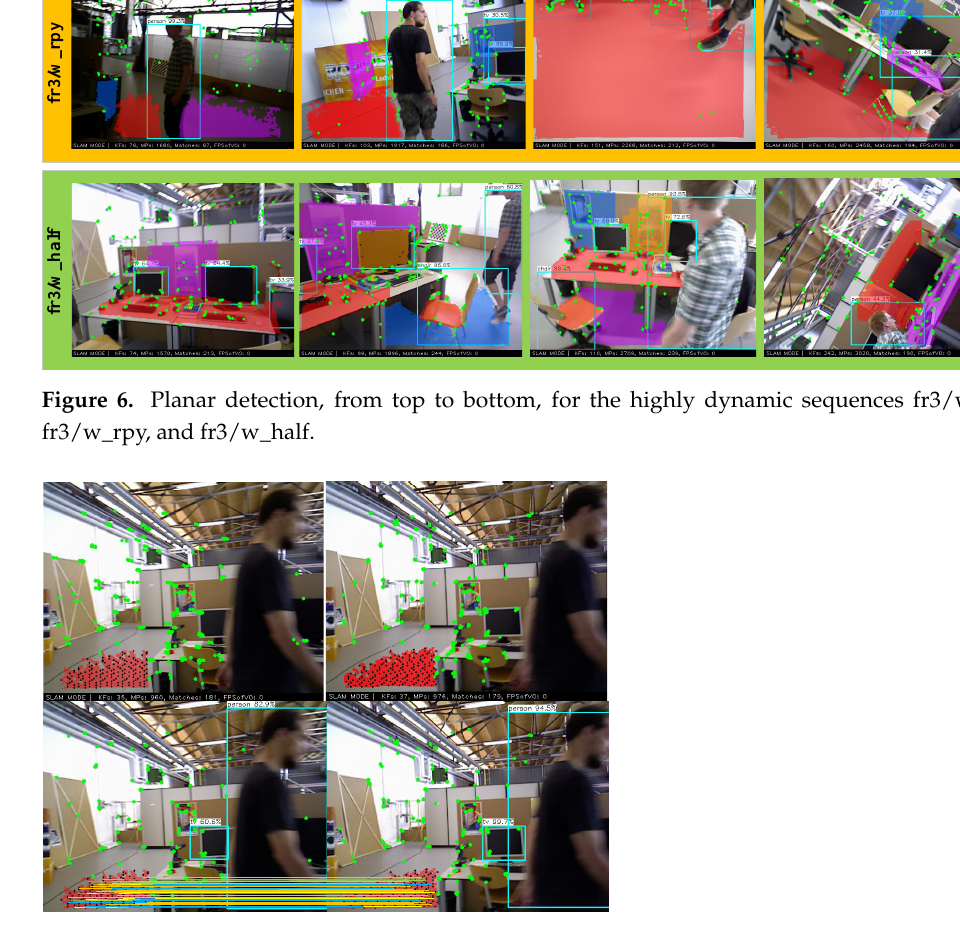
Figure 7. Points in the 3D plane that have been matched. Their matching relationship is expressed in RGB images in the form of two-dimensional coordinate lines.